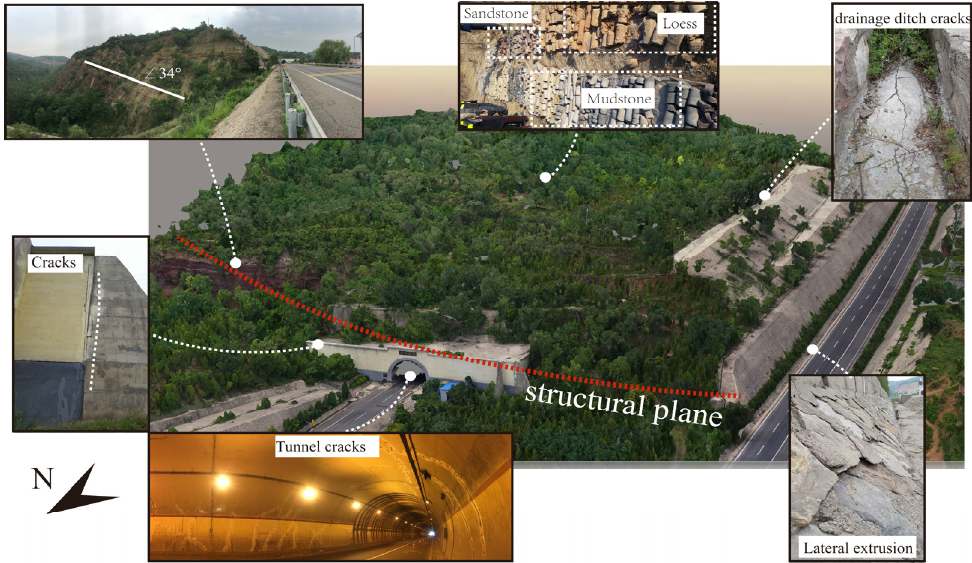
Figure 1. Tunnel and interface. This tunnel is named Goudong tunnel, which is located at Shanxi Province, China. It is a shallow-buried tunnel. An interface with dip angle of 34 ◦ between sandstone and mudstone cuts the tunnel, which causes numerous cracks in tunnel structure.